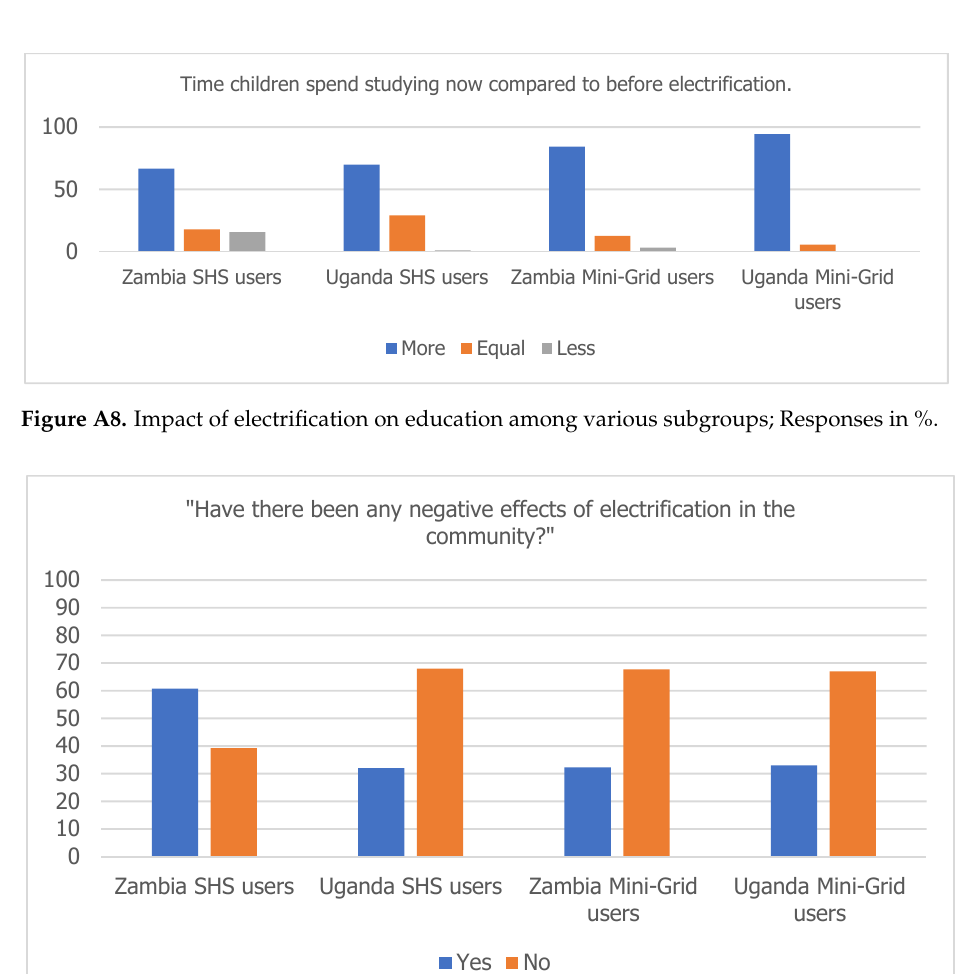
Figure A7. Impact of electrification on business activity among various subgroups; Responses in %.